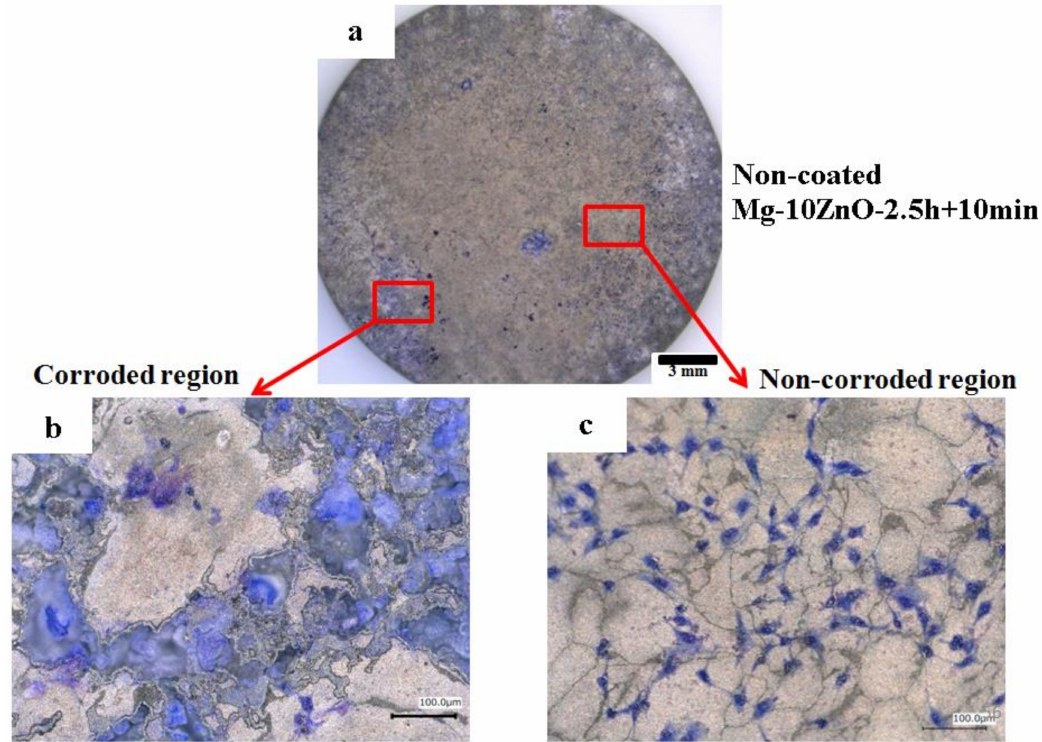
Figure 13. Morphology of the uncoated Mg-10ZnO-2.5 h + 10 min sample after 24 h of cell culture, ( a ) full surface image, ( b ) corroded region, ( c ) non-corroded